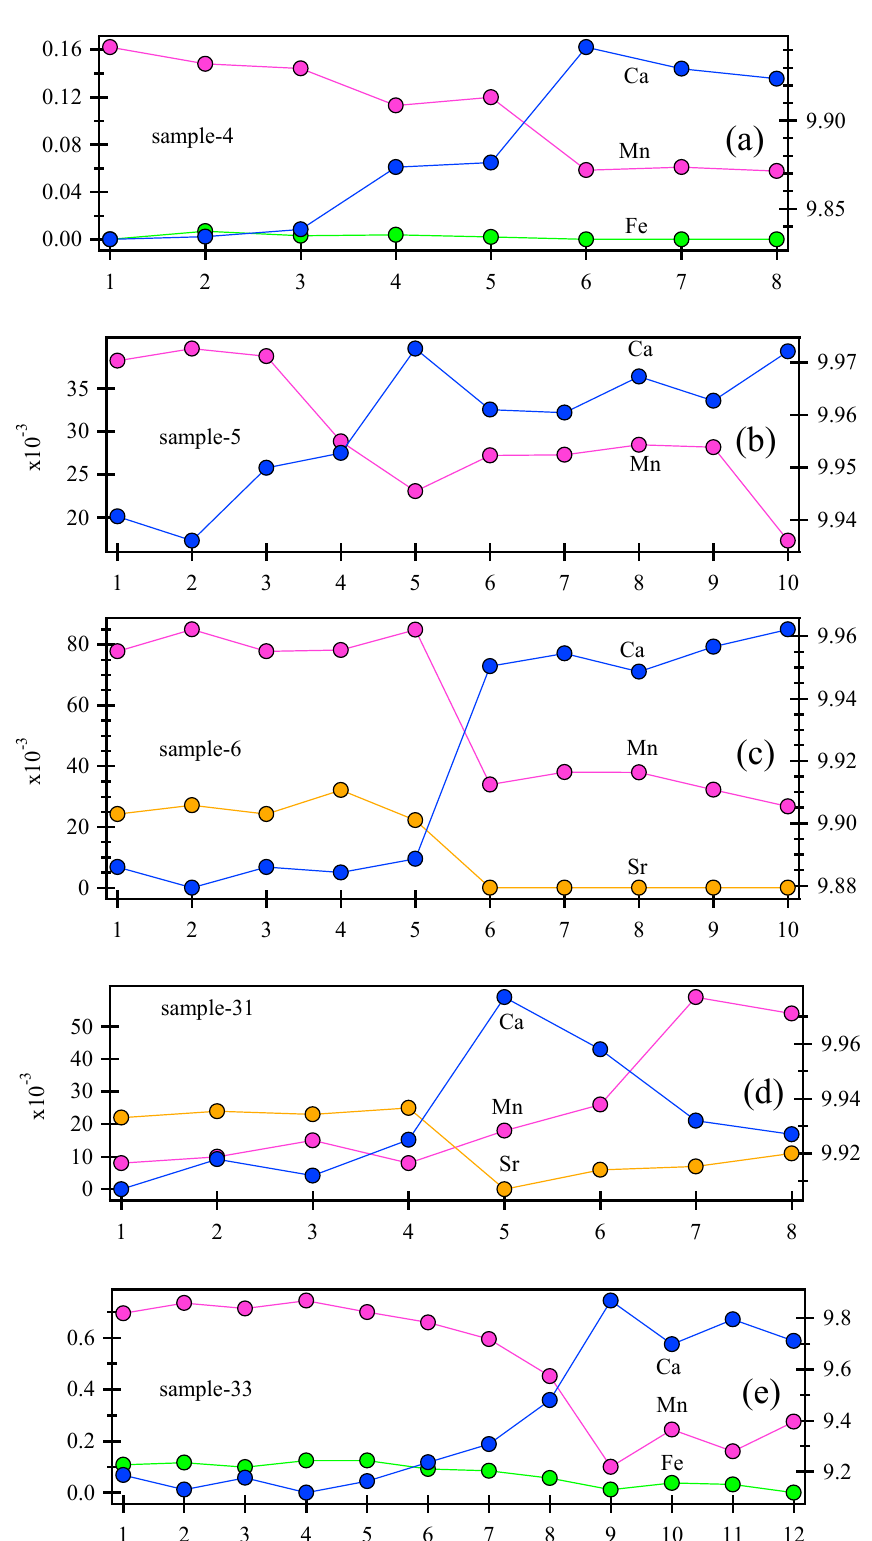
Figure 4. Variations of cations from different points (horizontal axis) in five different Ap samples (right-vertical axes are for Ca cations, and left-vertical axes are for the other cations). There are reciprocal relations between Ca and Mn cations in sample-4 ( a ), sample-5 ( b ), and sample-33 ( e ). The small amount of Fe cations is nearly constant in sample-4 and -33. The sum of Mn and Sr cations are high when the amount of Ca cations is low in sample-6 ( c ) and sample-31 ( d ).